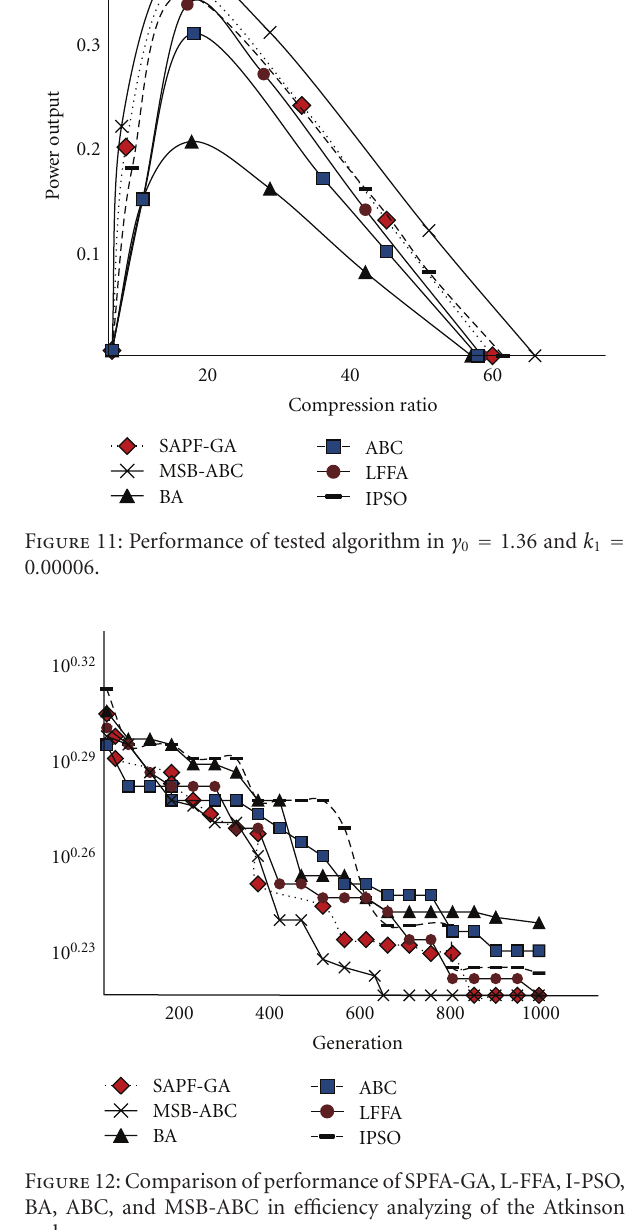
Figure 10: Comparison of performance of SPFA-GA, L-FFA, I-PSO, ABC, and MSB-ABC in e ffi ciency analyzing of the Atkinson cycle.